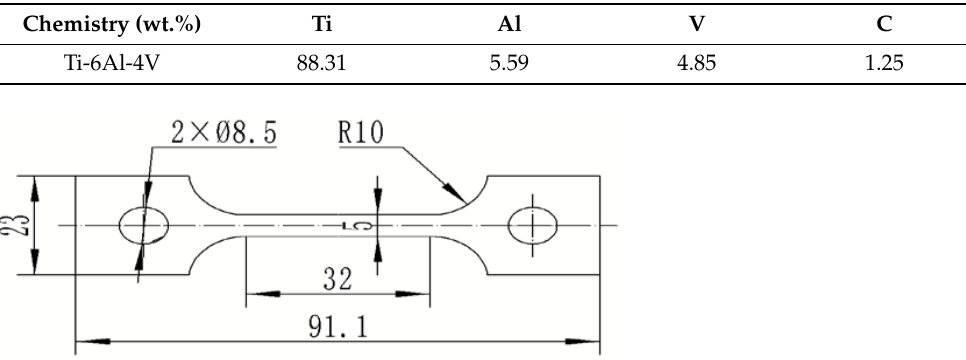
Table 2. The specimens for the hot temperature tensile tests were prepared by a wire elec- trical discharge machining method with the dimensions as detailed in Figure 2. Table 2. Chemical composition of the Ti-6Al-4V alloy. Table 2. Chemical composition of the Ti-6Al-4V alloy.